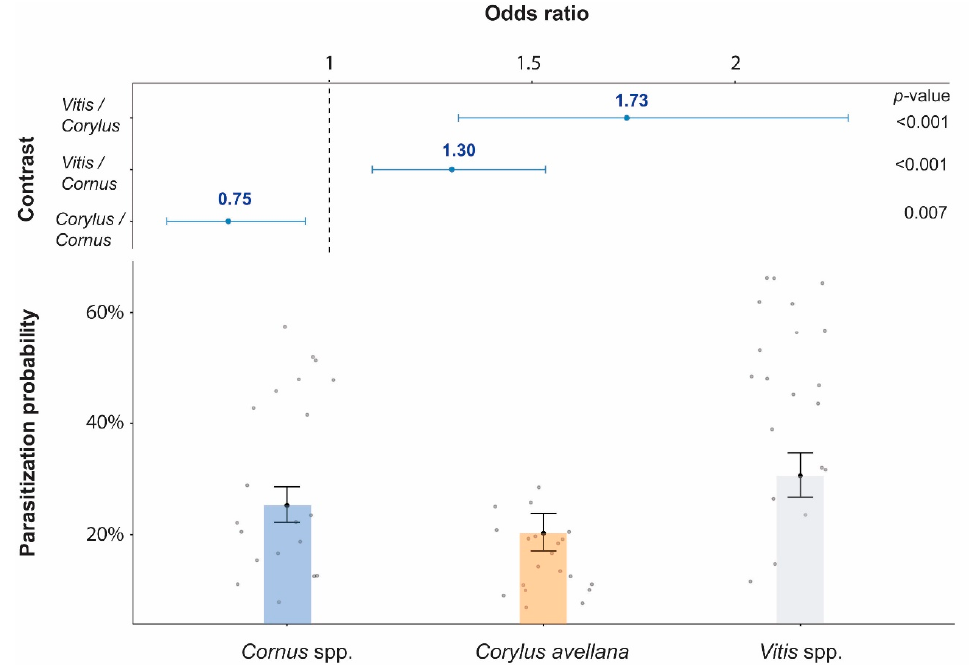
Figure 2. Top: the y-axis shows all pairwise comparisons among the three Plant Species levels, while the x-axis represents the response which is the Odds ratio of the means of the two groups of Plant Species in the comparison ( p -values from the hypothesis tests are included on the right). Bottom: the estimated marginal means of the parasitization probability on the three plant species are represented. Data are presented on the back-logit scale with 95% confidence intervals (CI). The raw data are plotted as grey dots. Model coefficients are provided in the Supplementary Material.